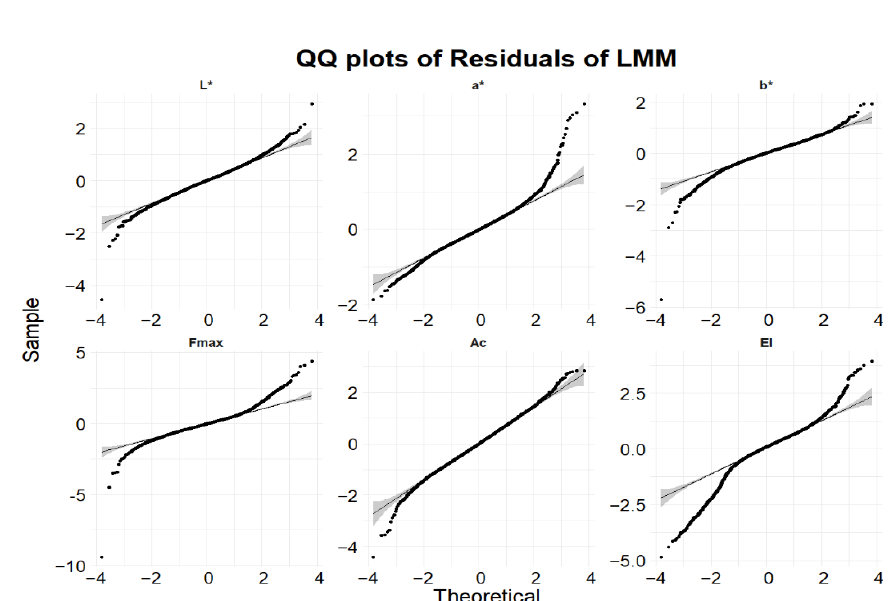
Figure A1. Q-Q plot of the normal distribution of each parameter.